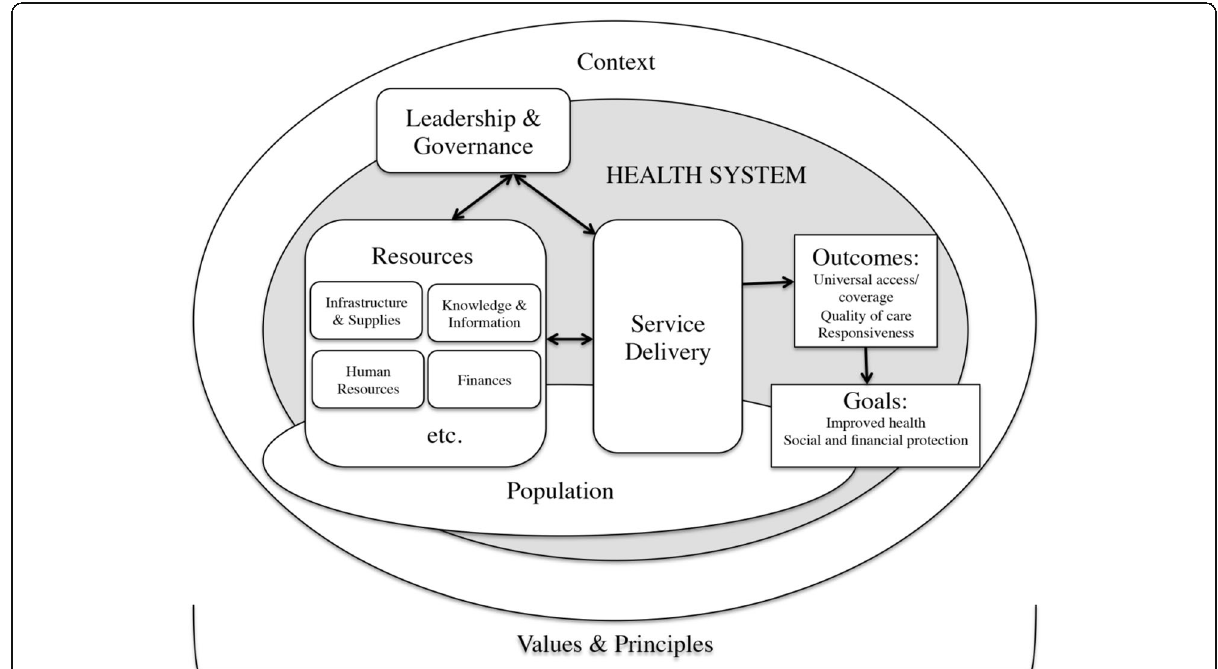
Fig. 1 The health system dynamics framework by van Olmen et al. (2012) in